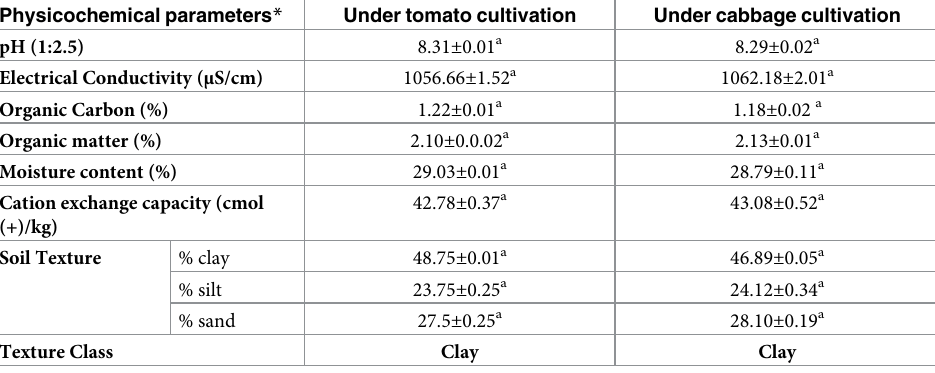
Table 2. Selected physicochemical properties of soils samples from farmlands around Mojo area in central